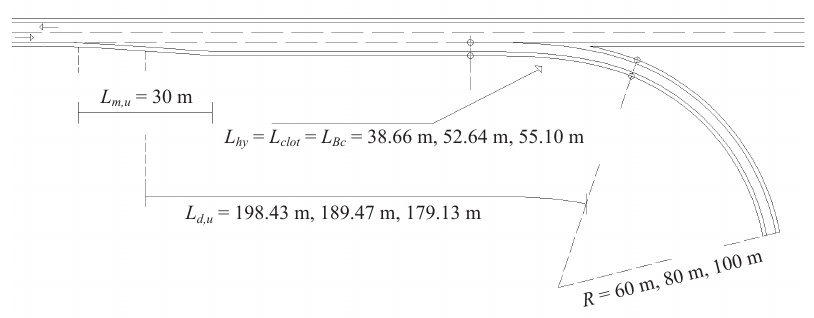
L d,u = 198.43 m, 189.47 m, 179.13